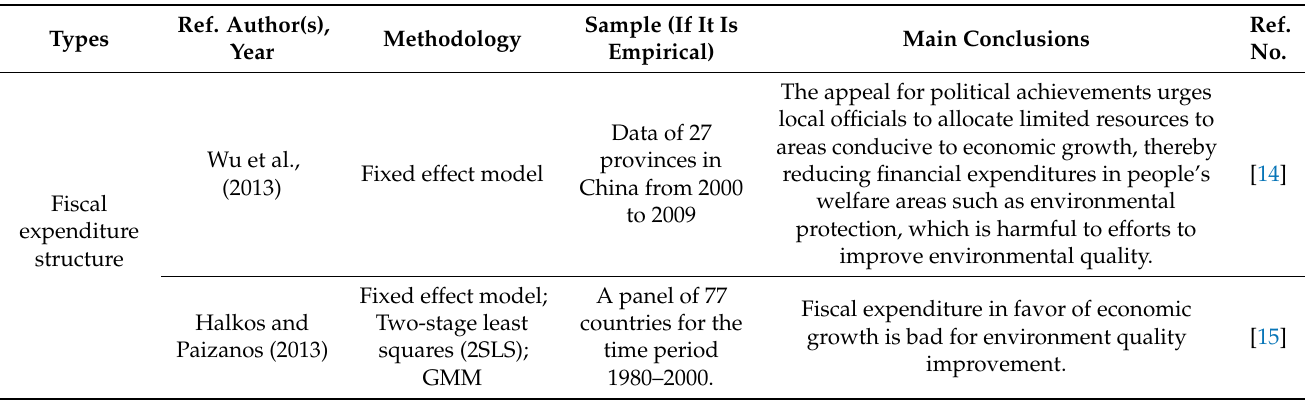
Table 1. Summary of the most important articles of the